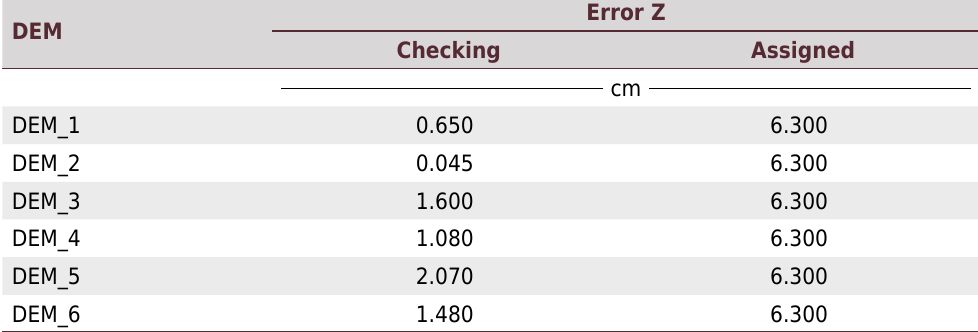
Table 3. Altimetric error obtained by the checkpoints and altimetric error attributed to DEMs DEM